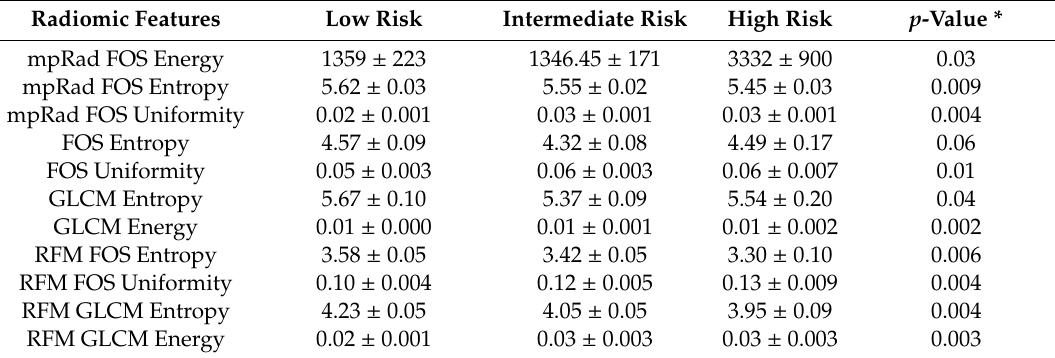
Table 2. Summary of entropy and uniformity radiomic features characterizing the heterogeneity or homogeneity of breast tumors across the different risk categories.